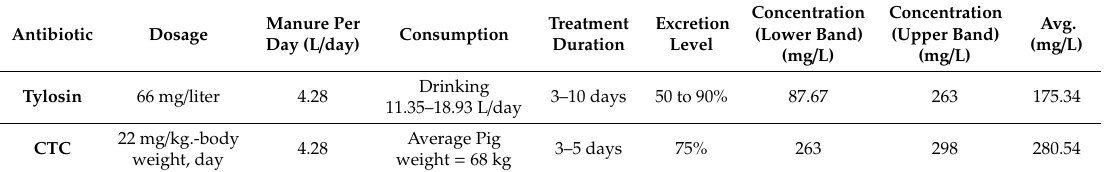
Table 2. Summary of antibiotics’ prescription and concentrations added every two days.